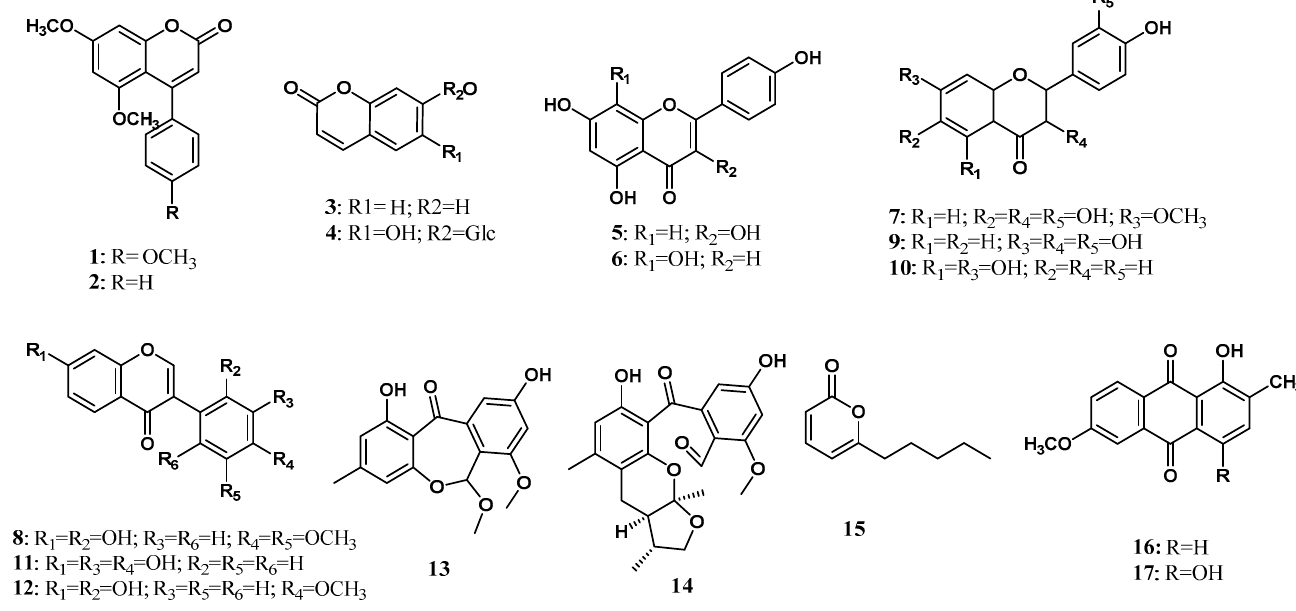
Figure 1. Polyketides from Zingiberaceae